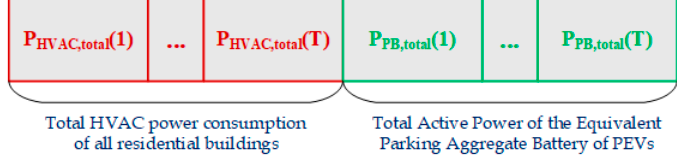
Figure 5. Particle structure used by the ADNM/A.